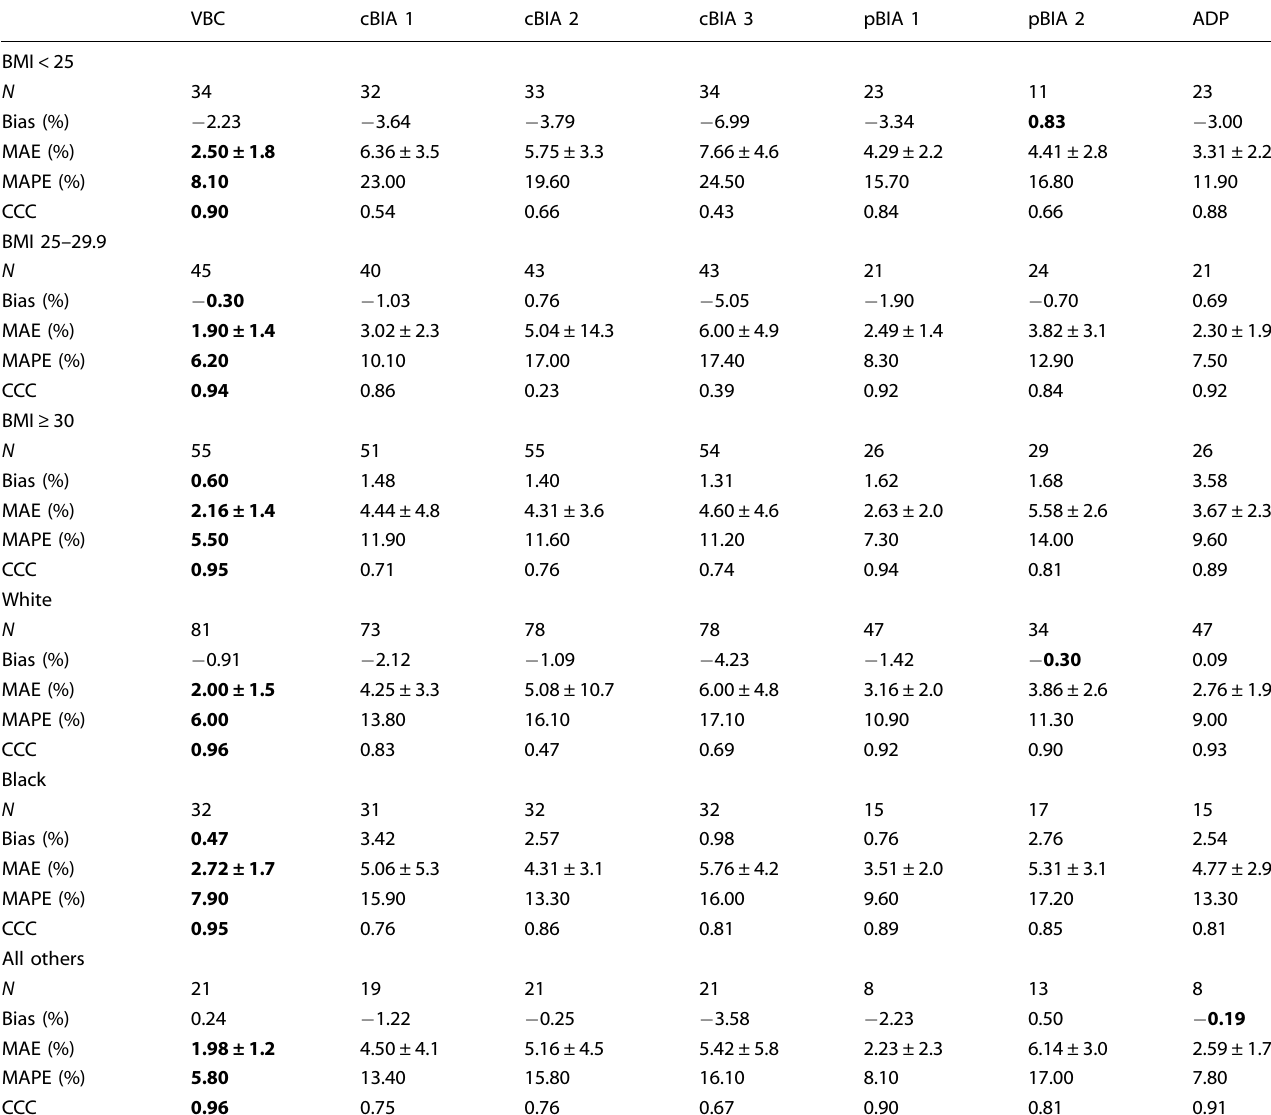
Table 3. Comparison of %BF estimates to DXA references strati fi ed by BMI and